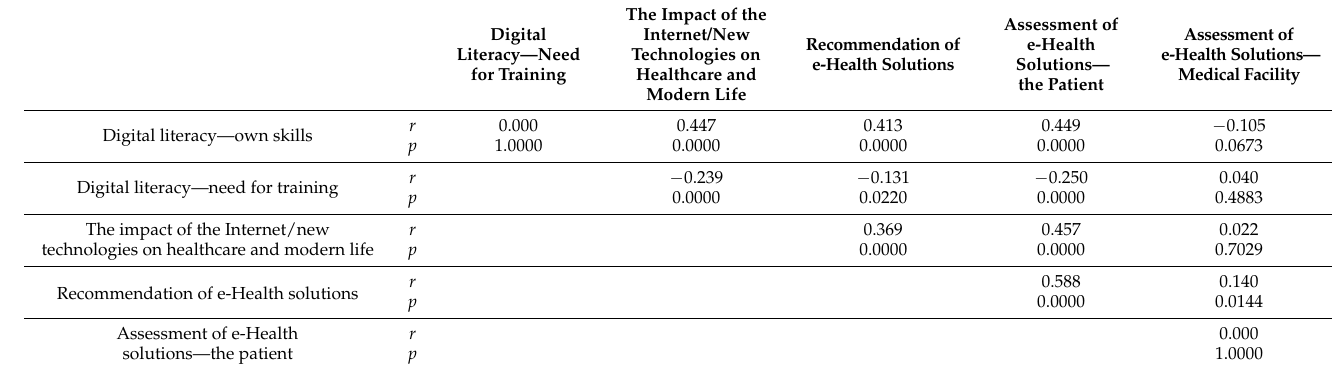
Table 9. Correlation matrix of all digital and e-Health